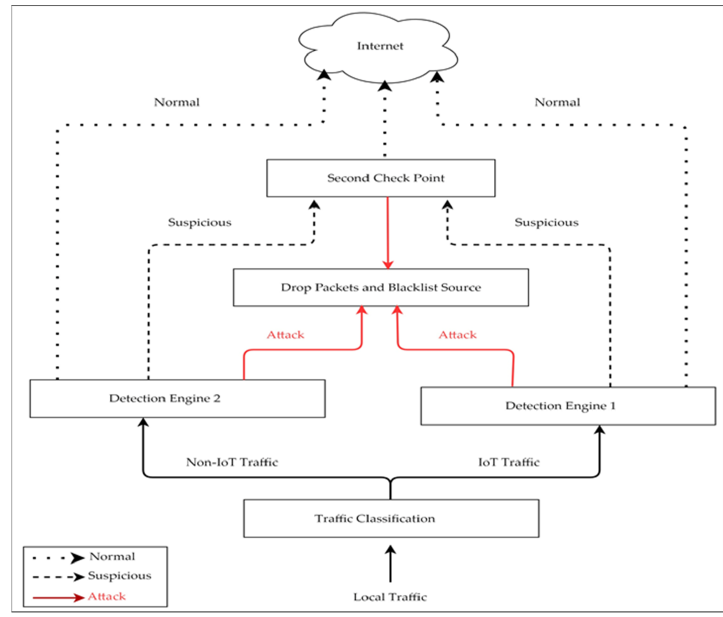
Figure 7. The proposed framework.